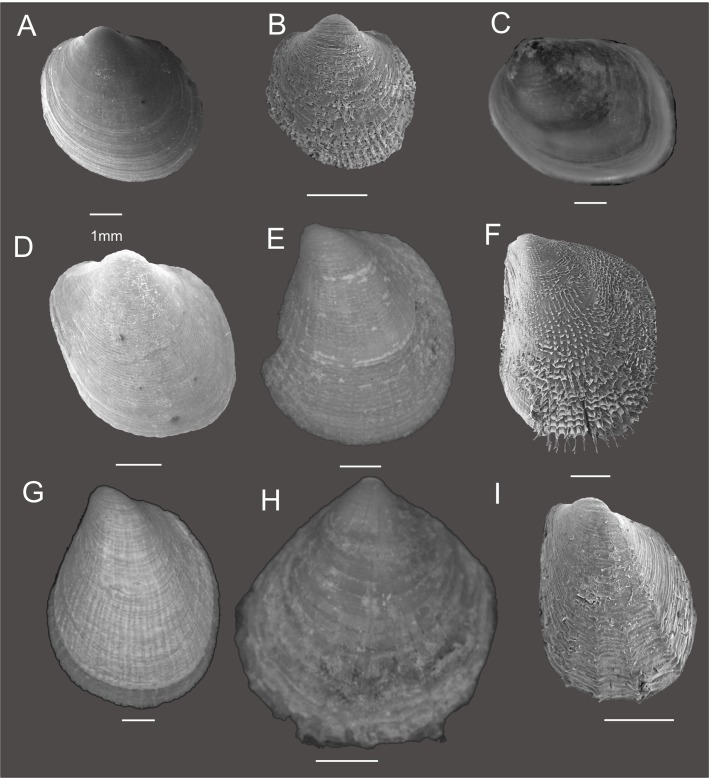
Philobryid shell morphology.Specimens labeled A-I refer to (A) Adacnarca nitens, (B) A. limopsoides (C) Lissarca miliaris (D) L. notorcadensis (E) Philobrya capillata (F) P. crispa (G) P. magellanica, (H) P. sublaevis and (I) P. wandelensis.